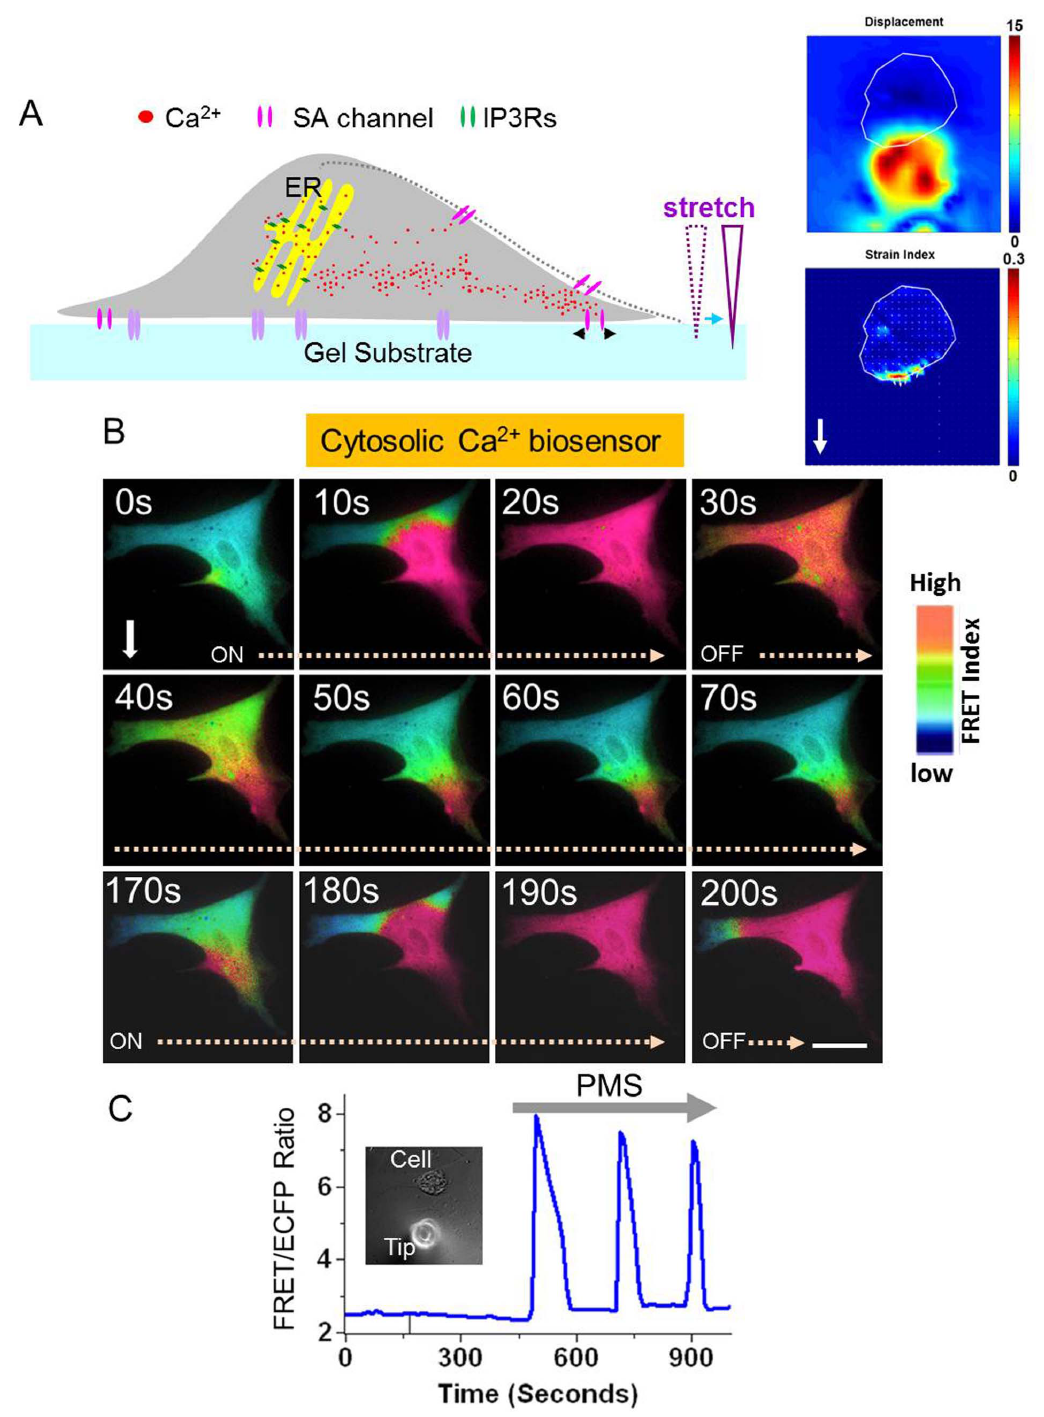
Figure 2. Prolonged mechanical stretch (PMS) triggers the calcium oscillations in hMSCs without spontaneous activities. (A) A schematic drawing of PMS application. Cells were seeded on polyacrylamide (PA) gels with 20 kPa of elastic modulus and a glass capillary probe tip can be placed near a cell and inserted in the gel to pull the gel and cause the stretch of the target cell. The right images show typical displacement and strain maps during prolonged mechanical stretch. The cold and hot colors represent the small and large relative displacement (top, 0–15 m m) and strain index (bottom, 0–0.3). (B) Mechanical stretch was applied to the cytosolic FRET biosensor-transfected hMSC and intracellular calcium dynamics were visualized by the FRET ratio. High FRET ratio (Red color) denotes high concentration of calcium. White arrow points to the direction of mechanical stretch. ON: calcium increase, OFF: calcium decrease. Scale bar, 20 m m. (C) The time course shows that PMS triggers the calcium oscillations in a cell without spontaneous activities. DIC image shows the cell and the probe tip on the PA gel.